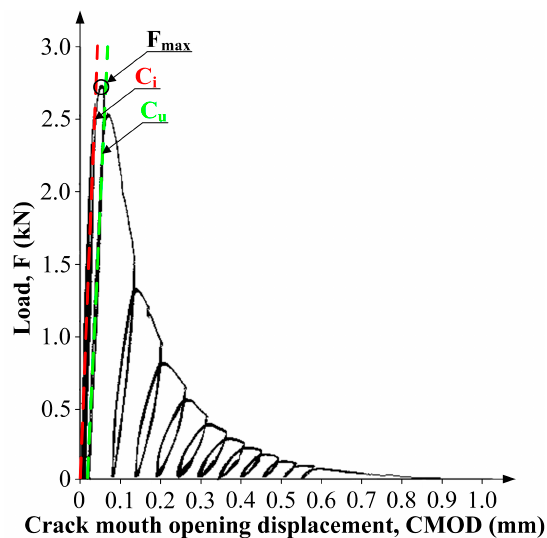
Figure 6. An example graph of CMOD-load relationship obtained in the tests at mode I fracture.